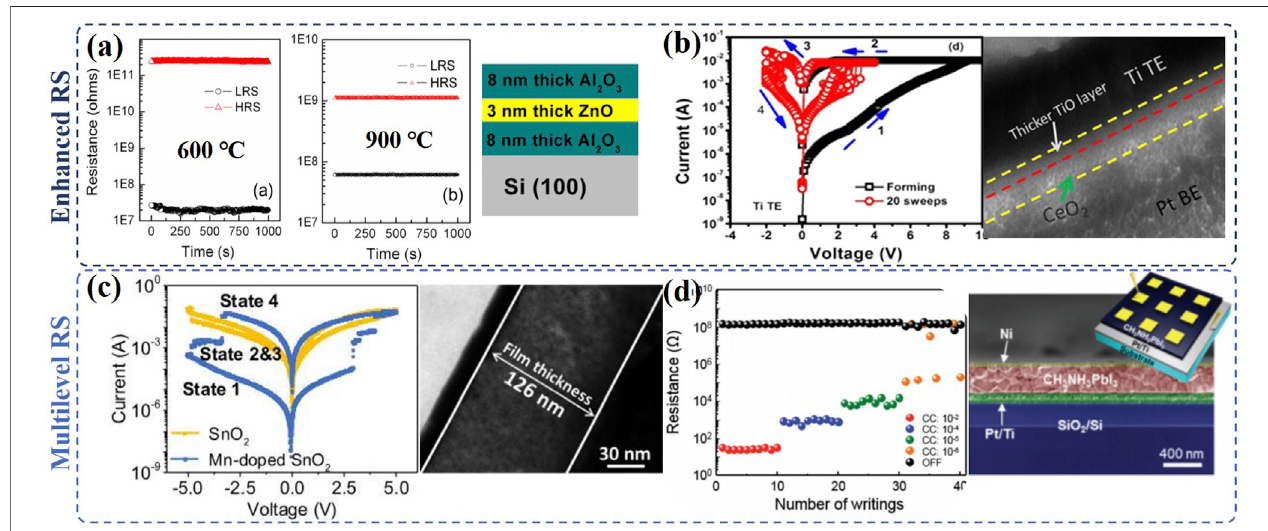
FIGURE 2 | Enhanced RS performance and the cross-section images of the device based on (A) Al 2 O 3 /ZnO/Al 2 O 3 memristors (reproduced with permission (Sekharetal.,2015).Copyright2015,ElsevierB.V.)and (B) CeO 2 /Ti/CeO 2 (reproducedwithpermission(Ranaetal.,2017).Copyright2017,AnwarManzoorRanaetal.); the multilevel RSand the cross-section images ofthe device based on (C) Mn-doped SnO 2 (reproduced with permission (Xu et al., 2018).Copyright 2018, Elsevier Ltd.) and (D) CH 3 NH 3 PbI 3 thin fi lms (reproduced with permission (Choi et al., 2016). Copyright 2016, John Wiley & Sons, Inc.).